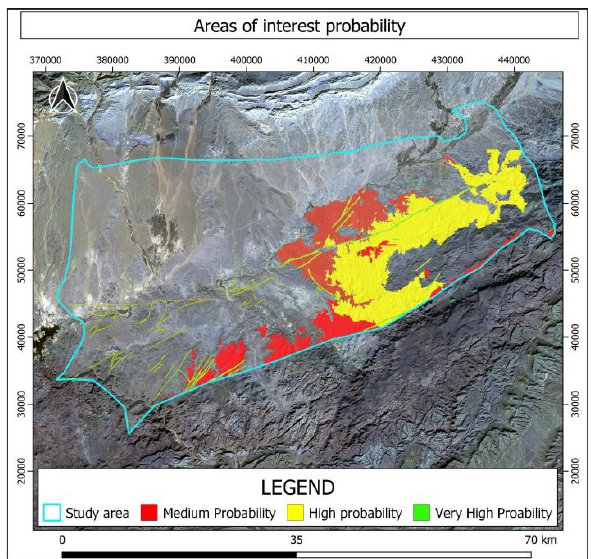
Figure 13: Mineral map predicted using Random Forest (Generated and reclassed in GIS Software).